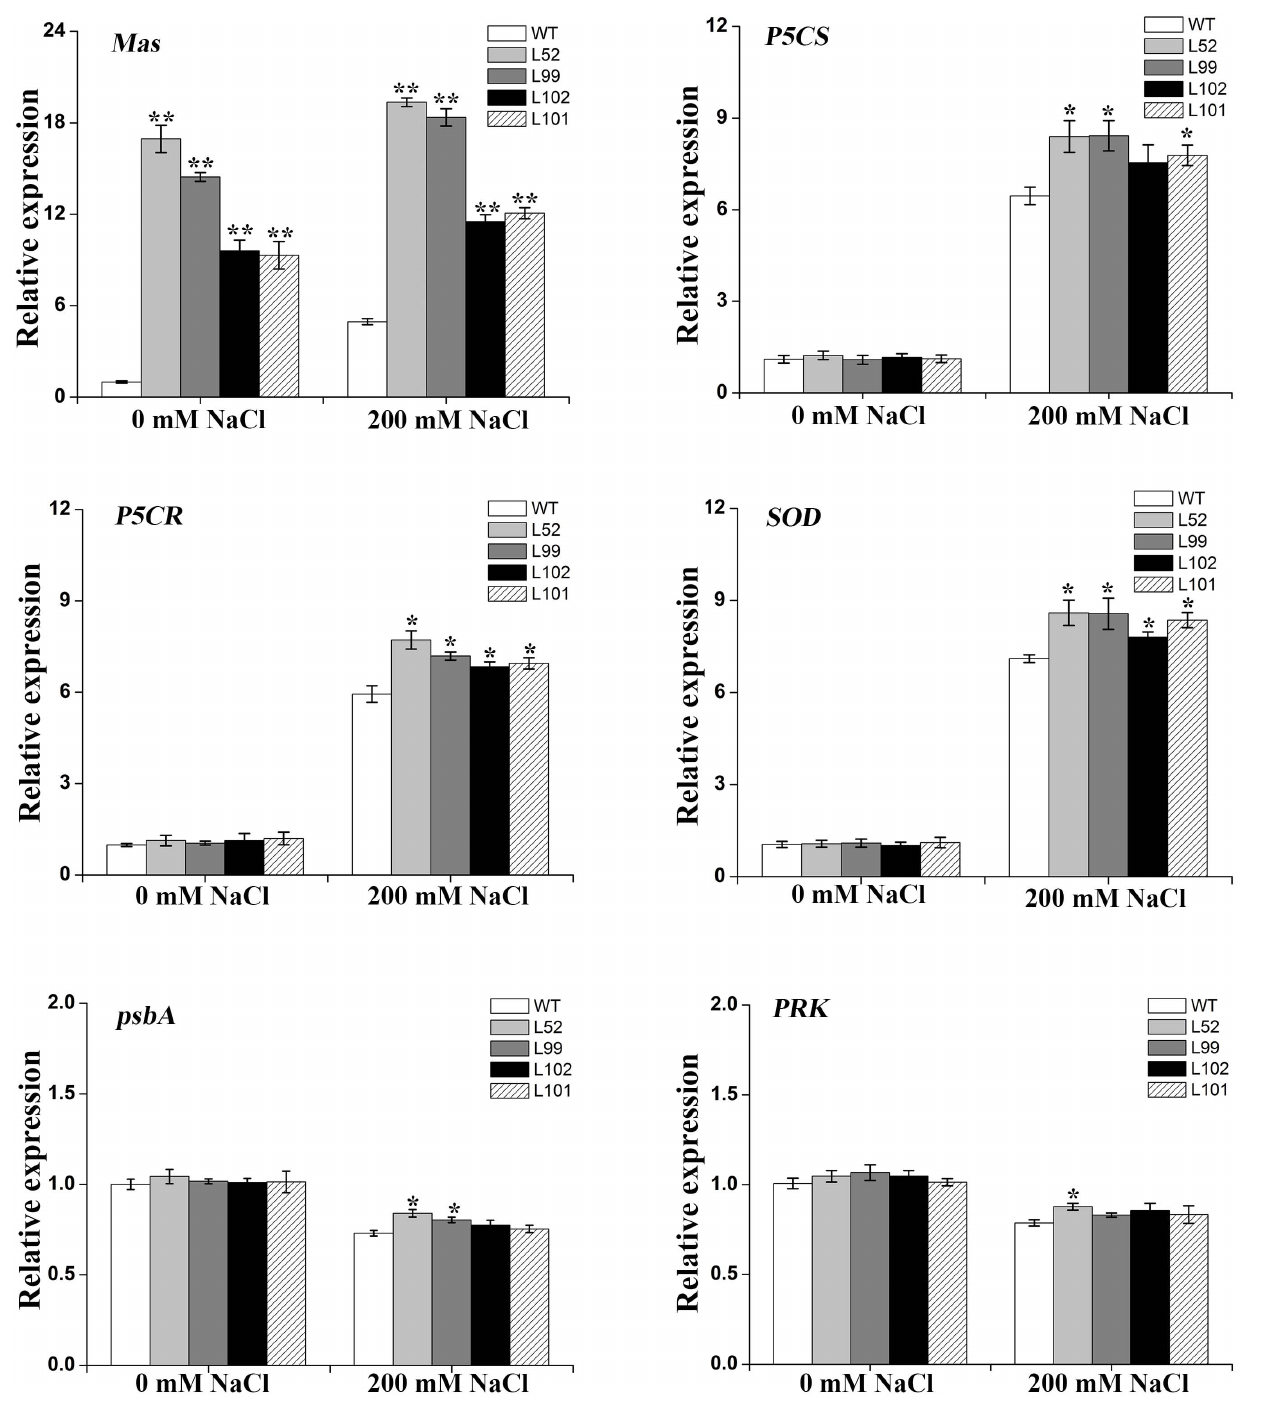
Fig. 11. Relative expression level of IbMas and salt stress responsive genes in the IbMas -overexpressing sweetpotato plants. P5CS : pyrroline-5- carboxylate synthase; P5CR : pyrroline-5-carboxylate reductase; SOD : superoxide dismutase; psbA : encoding D1 protein; PRK : phosphoribulokinase (PRKase). The salt-tolerant transgenic plants (L52, L99, L102 and L101) and wild-type plant (WT) in vitro-grown plants were submerged for 12 h in 1/2 MS medium containing 0 and 200 mM NaCl, respectively. The sweetpotato b -actin gene was used as an internal control. The results are expressed as relative values based on WT grown under control condition as reference sample set to 1.0. Data are presented as means ¡ SE (n 5 3). * and ** indicate a significant difference from that of WT at P , 0.05 and , 0.01, respectively, by Student’s t -test.